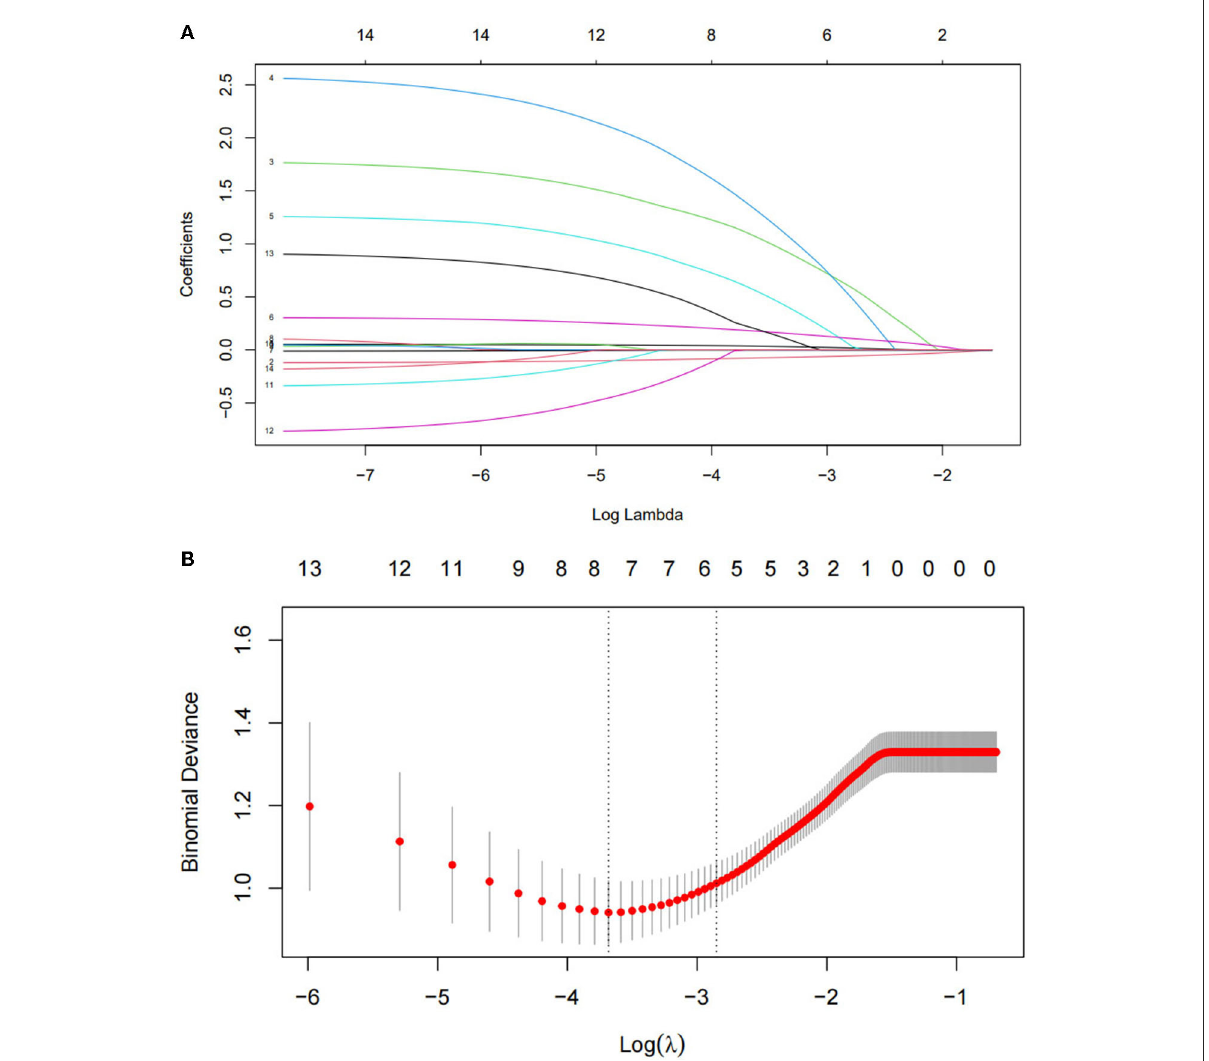
FIGURE2 Optimal parameter (lambda) selection in the least absolute shrinkage and selection operator (LASSO) model (A) . Identification of the optimal penalization coefficient in the LASSO model was achieved by 10-fold cross-validation and the minimum criterion. The left vertical line represents the mean-squared error, and the right vertical line represents the cross-validated mean-squared error within 1 standard error of the minimum (B) .